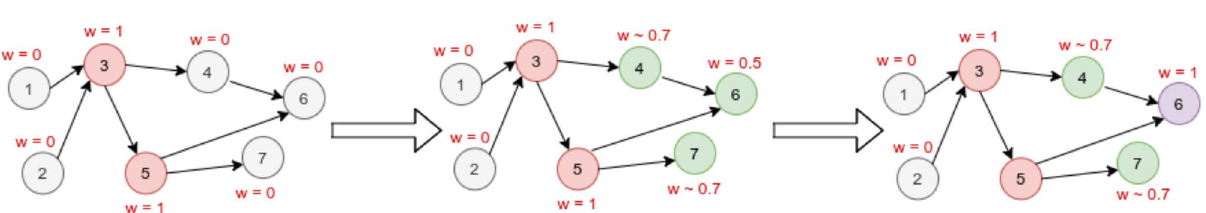
Figure 5. An example of how a message passing framework functions. The numbers inside the circles indicate nodes’ IDs. ‘w’ indicates the node feature weight (as described in section “The message passing framework/ module”). In the first iteration, new weights for nodes 4, 6, 7 are calculated according to equation (1). Only the weight for node 6 gets updated during the second